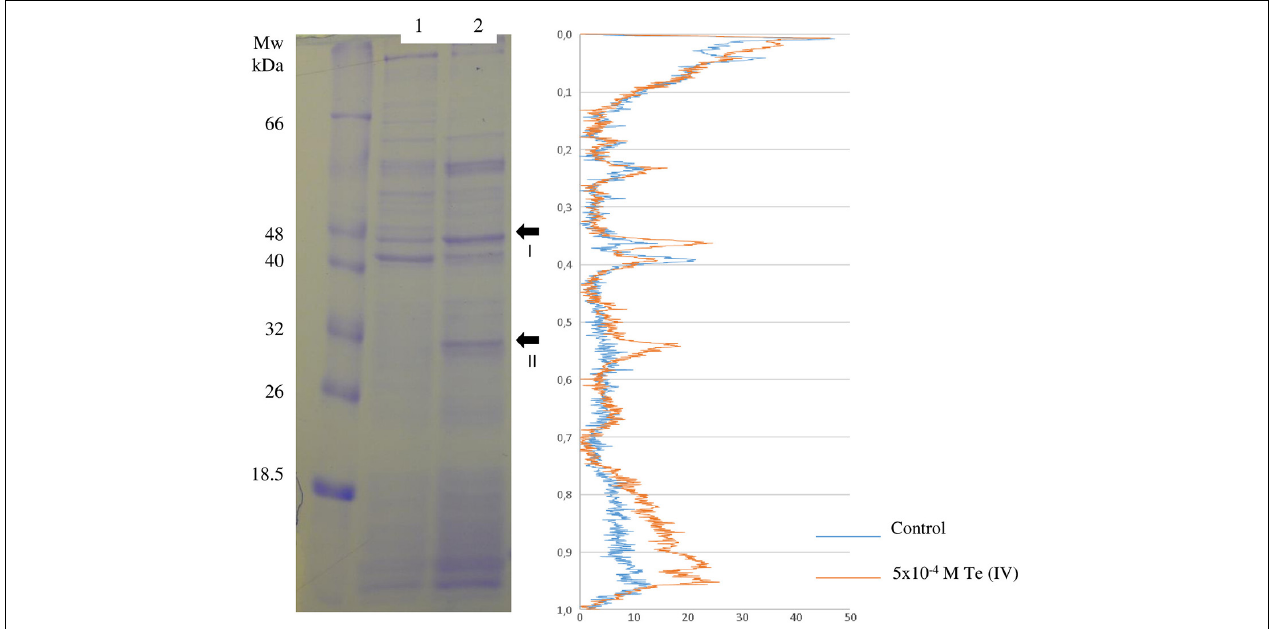
FIGURE 4 | Differential expression of total proteins from Paenibacillus pabuli ALJ109b. (Right) Denaturing gel comparing total protein from (1) Control (without metal) and (2) 5 × 10 − 4 M Te (IV). Fragments indicated in lane 2 (arrows) were excised, purified, and identified by MS/MS, with resulting identification in the table. (Left) Lane comparison of band intensities and densitogram, from control (blue) and metal treatment (orange).